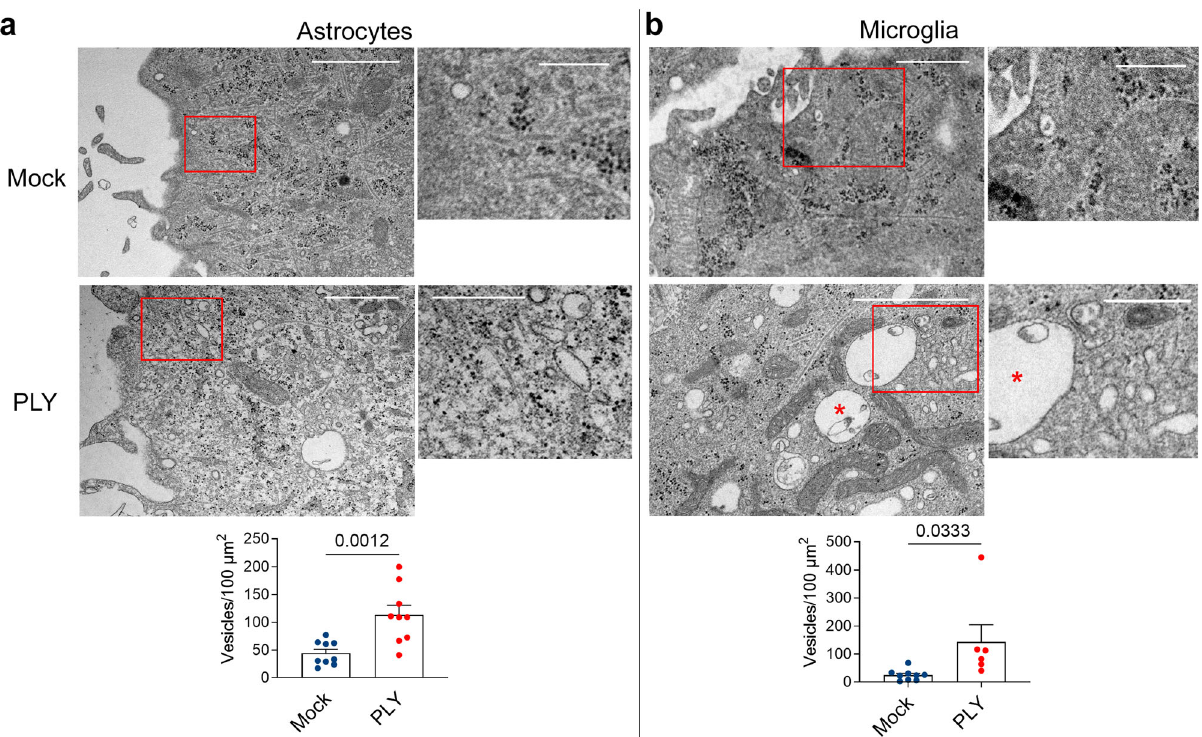
Fig. 4 | Transmission electron microscopy of glial cells after recombinant PLY exposure. TEMinastrocytes( a )andmicroglia( b )demonstrateselevatednumbers of vesicular structures with sizes <500nm, corresponding to clathrin-coated vesi- cles,caveolarvesicles,andearlyendosomes.Theredsquareismagni fi edtwofoldin the smaller adjacent image. All values represent the mean±SEM, each dot symbol